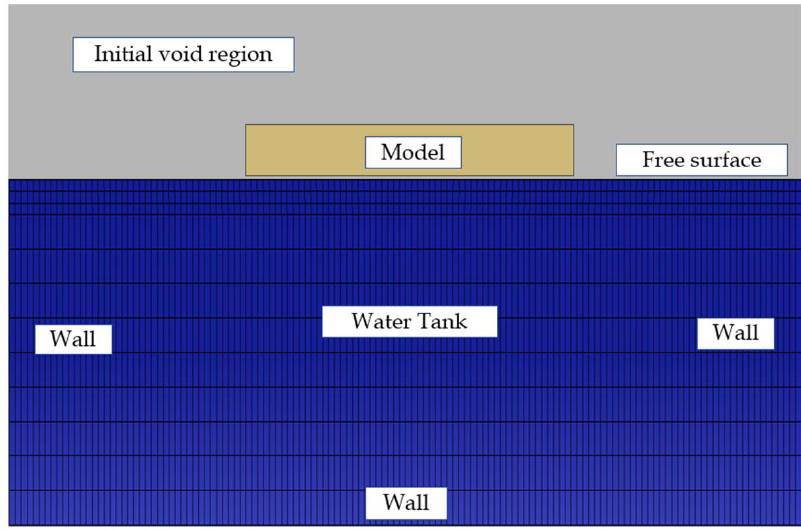
Figure 3. Computational domain and boundary conditions.